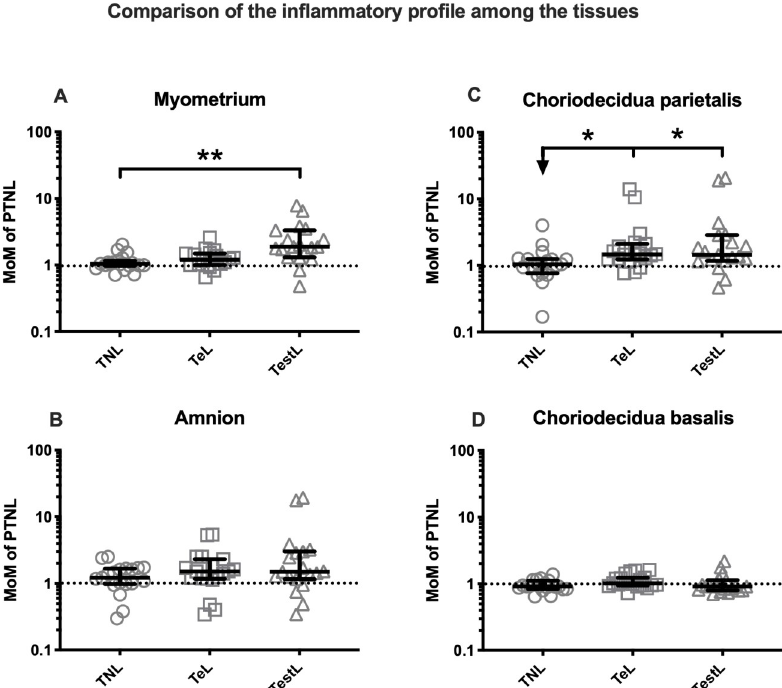
Fig 10. Comparison of the inflammatory changes in the tissues during pregnancy and labour. The multiples of median (MOM) were used to compare the inflammatory changes during gestation, early labour and established labour in each tissue. The median value of PTNL was used to normalise the data across the comparison groups (TNL, TeL and TestL). The median ranges were then used for all the 20 cytokines and comparisons between 2 or more groups were performed using the Kruksal-Wallis test with a Dunn’s Multiple Comparison post hoc test as the data was non- parametric. In the graphs, the p values are demonstrated by � where � is p < 0.05, �� is p < 0.001 and ��� is p < 0.0001.